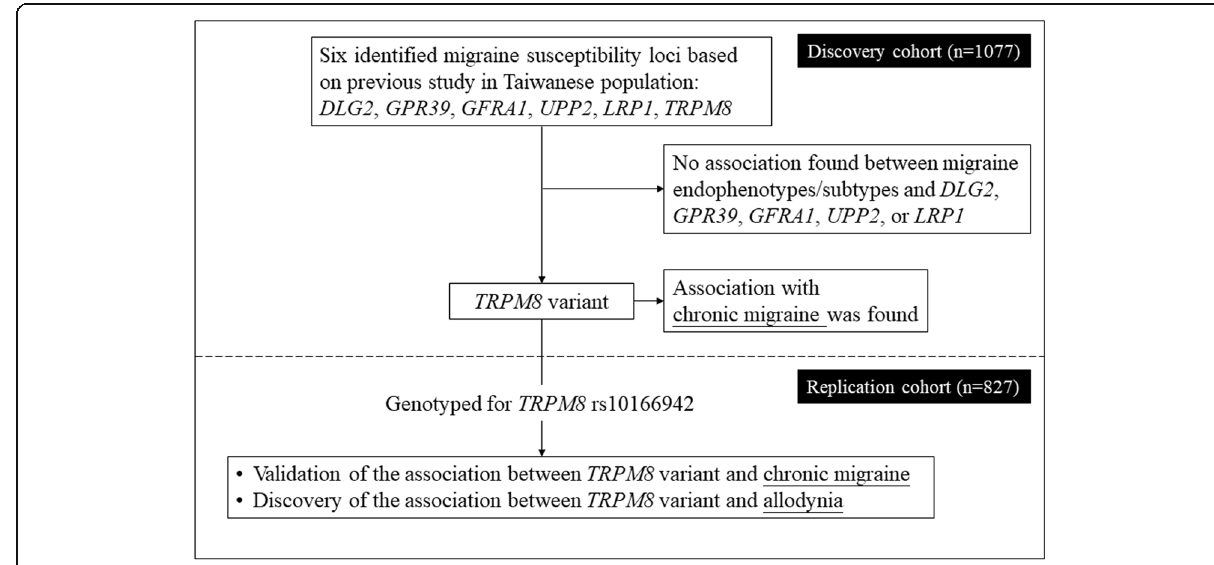
Fig. 1 Study design and main findings of the